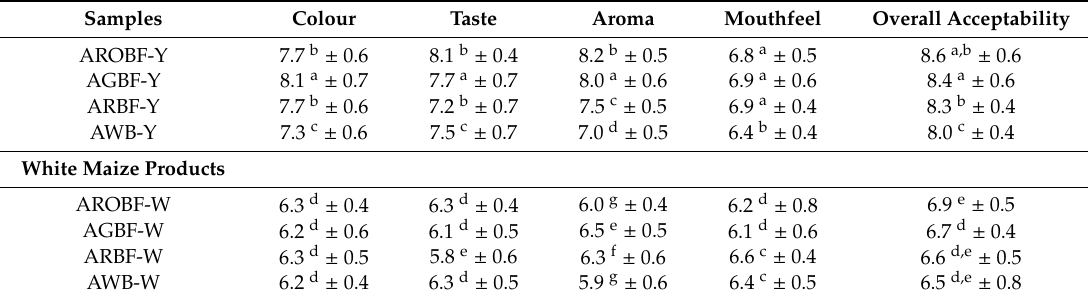
Table 5. Consumer acceptability of amahewu samples.